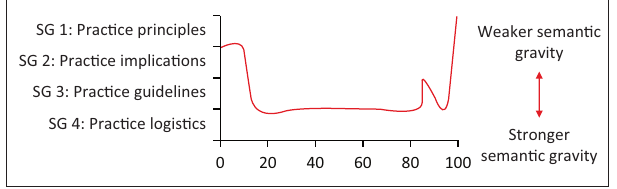
FIGURE 2: The semantic gravity profile of comprehension across the Curriculum and Assessment Policy Statement document.